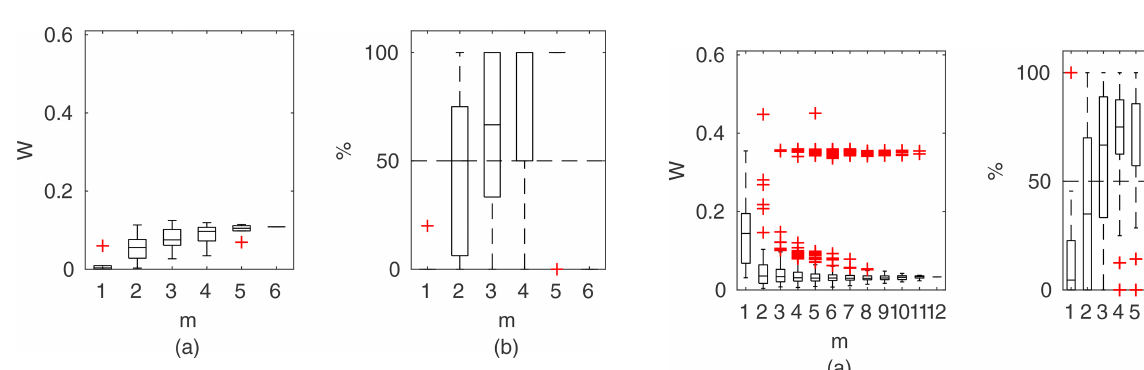
Figure B16. GTLM results for the Ritobacken case study, autumn 2011: (a) averaged relative confidence widths W as a function of ob- servation set size m used for model identification; (b) percentage of verification points enclosed by the confidence intervals (100% de- notes all points within intervals, box spans over the 25% and 75% quantiles, the median is given with horizontal line, whiskers indi- cate the result extent, and cross marks are for extreme